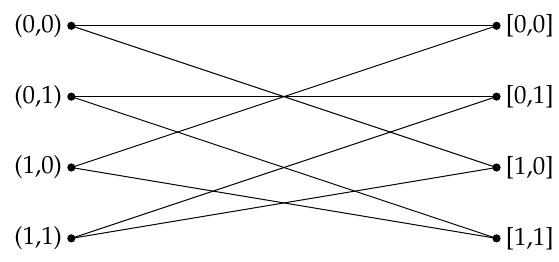
Figure 1. The graph B Γ 2 ( R ; p 1 l 1 )